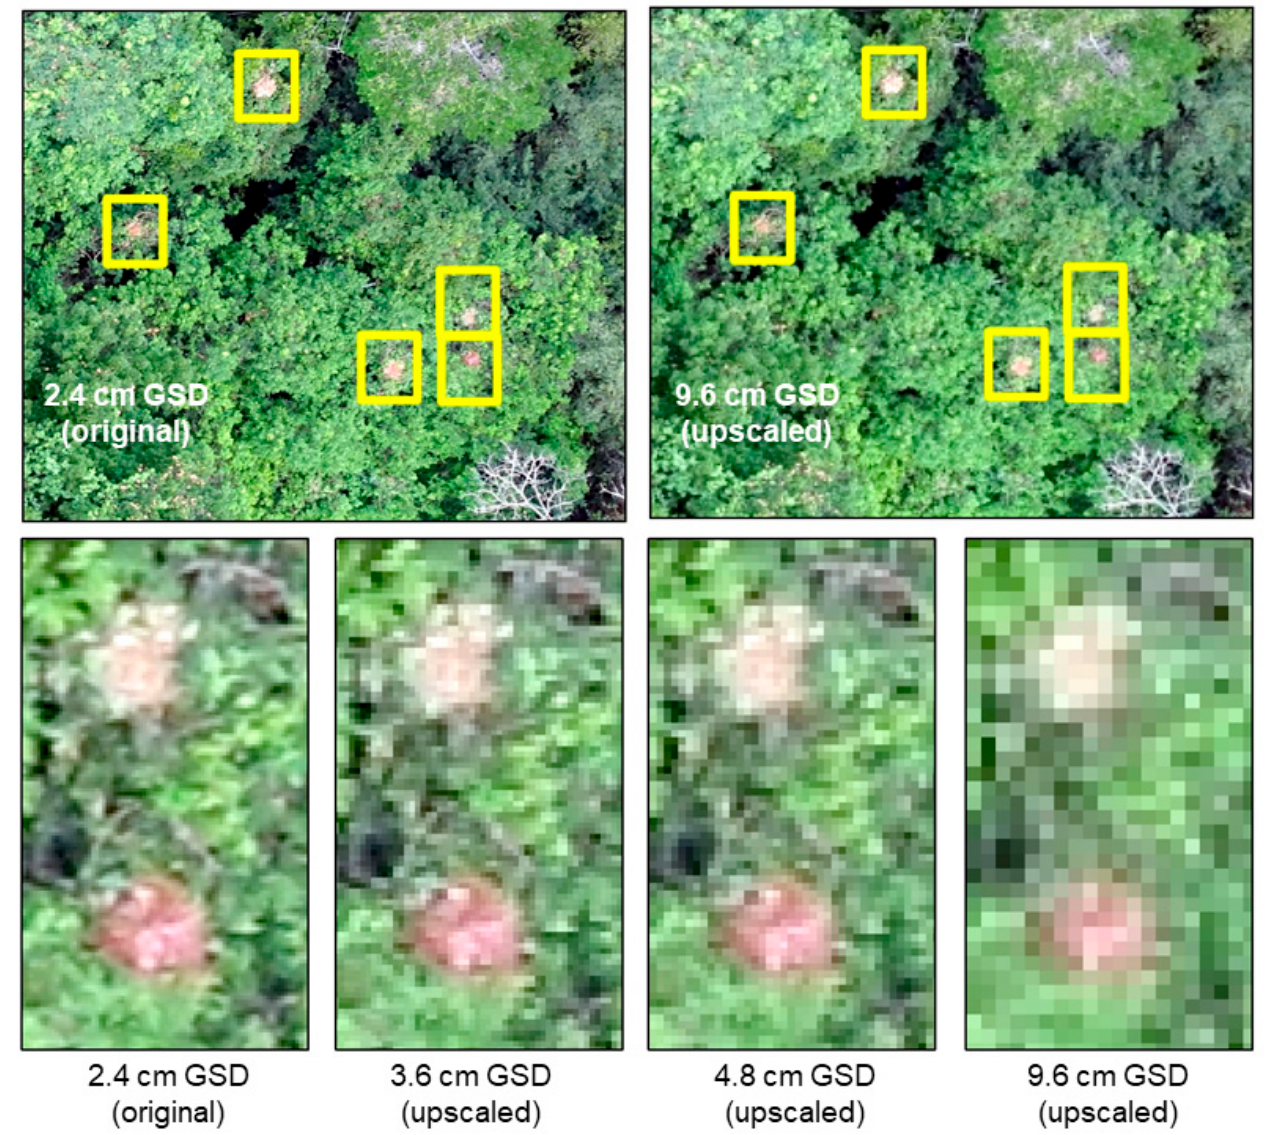
Figure 2. Simulated impacts on ground sampling distance (GSD) with increasing flight altitude or using a camera with a shorter focal length. Original imagery of nest IDs is presented next to this imagery upscaled to increasingly coarse GSD. Nest detection can be visually challenging even for trained observers. While potential nests may be visible in imagery with near decimetre GSD, validation of these as ‘true nests’ is extremely challenging, even when nests are located on a contrasting background like that pictured above. Many nests are likely missed due to being located in difficult-to-interpret contexts, and GSD likely impacts both initial detection and validation probabilities. To make this figure, we imported the original scaled image into ArcMap and exported it with pixel size multipliers of 1.5, 2, 3, and 4.